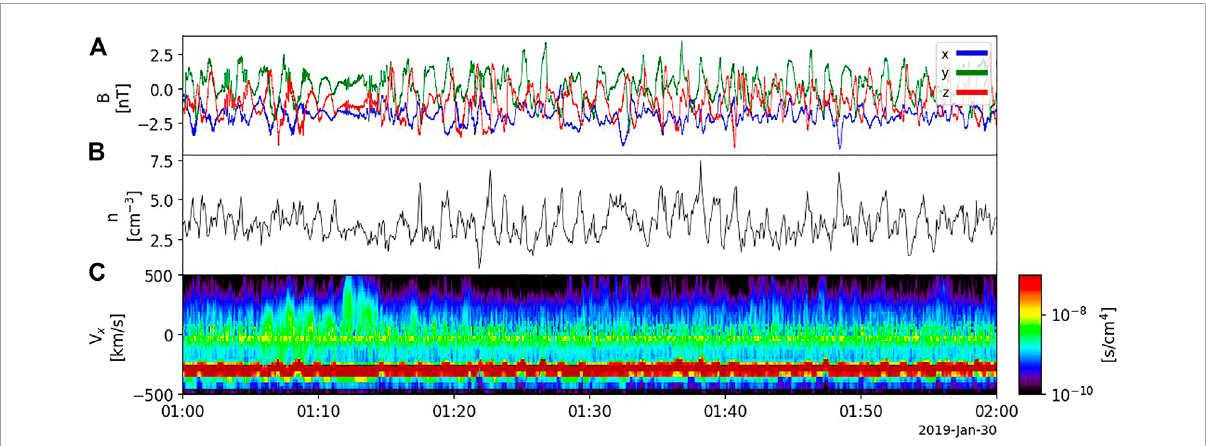
FIGURE 1 Example of RHI waves typical of the quasi-parallel foreshock as observed by the MMS2 spacecraft. The magnetic field in (A) is primarily in the x direction with large-amplitude waves in B y and B z . The total ion density it plotted in (B) . The reduced ion velocity distribution in terms of v x is plotted in (C) . In the spacecraft frame, the background moves in the − v x direction while the beam population is centered near v x = 0. The reflected beam ions have a relatively broad velocity spread compared to the colder solar wind